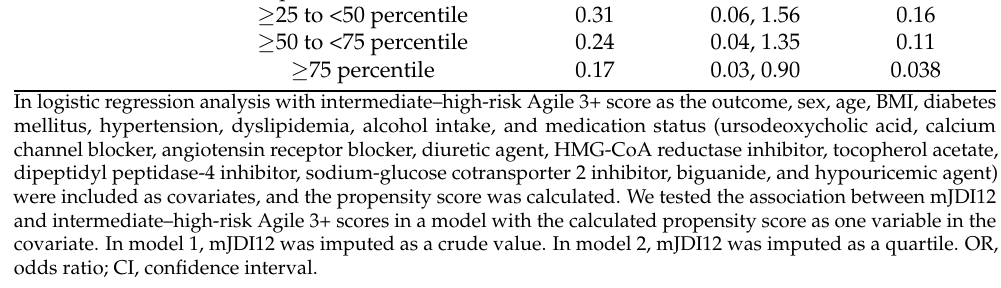
Table 4. Logistic regression analysis of mJDI12 for intermediate–high-risk Agile 3+ scores. OR 95% CI p Value model 1 mJDI12 0.77 0.61, 0.99 0.04 model 2 <25 percentile